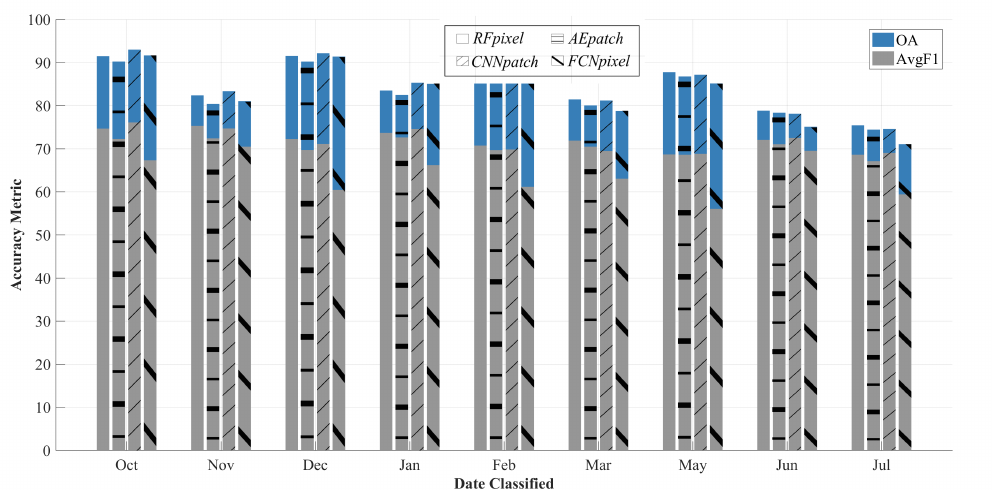
Figure 11. OA and average F1-score at each date—Protocol II. From left to right in each bar-group RFpixel , AEpatch , CNNpatch and FCNpixel repectively.